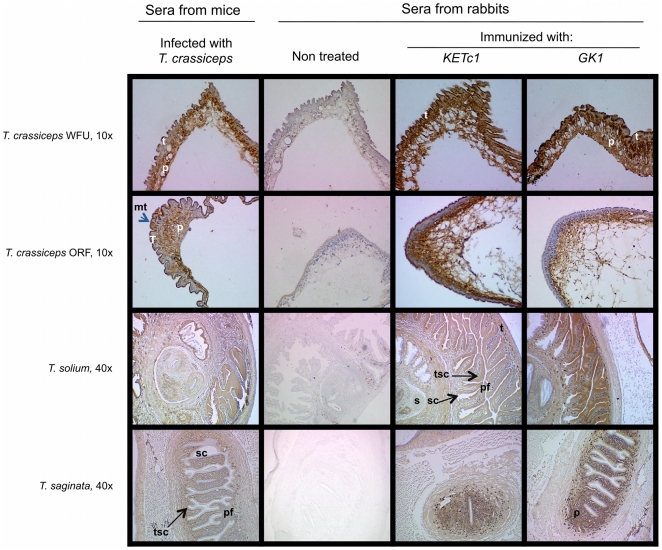
S3Pvac peptides were detected in the tegument of Taenia tapeworms and T. solium eggs.No reaction was detected in control sections, for which naive rabbit serum was used in place of the specific polyclonal rabbit serum. S.- Sucker; Sc. Scolex, MP.- Medullar parenchyma, N.- Neck; DC.- Distal cytoplasm region; PE.- perinuclear cytoplasm region. O.- oncospheres.